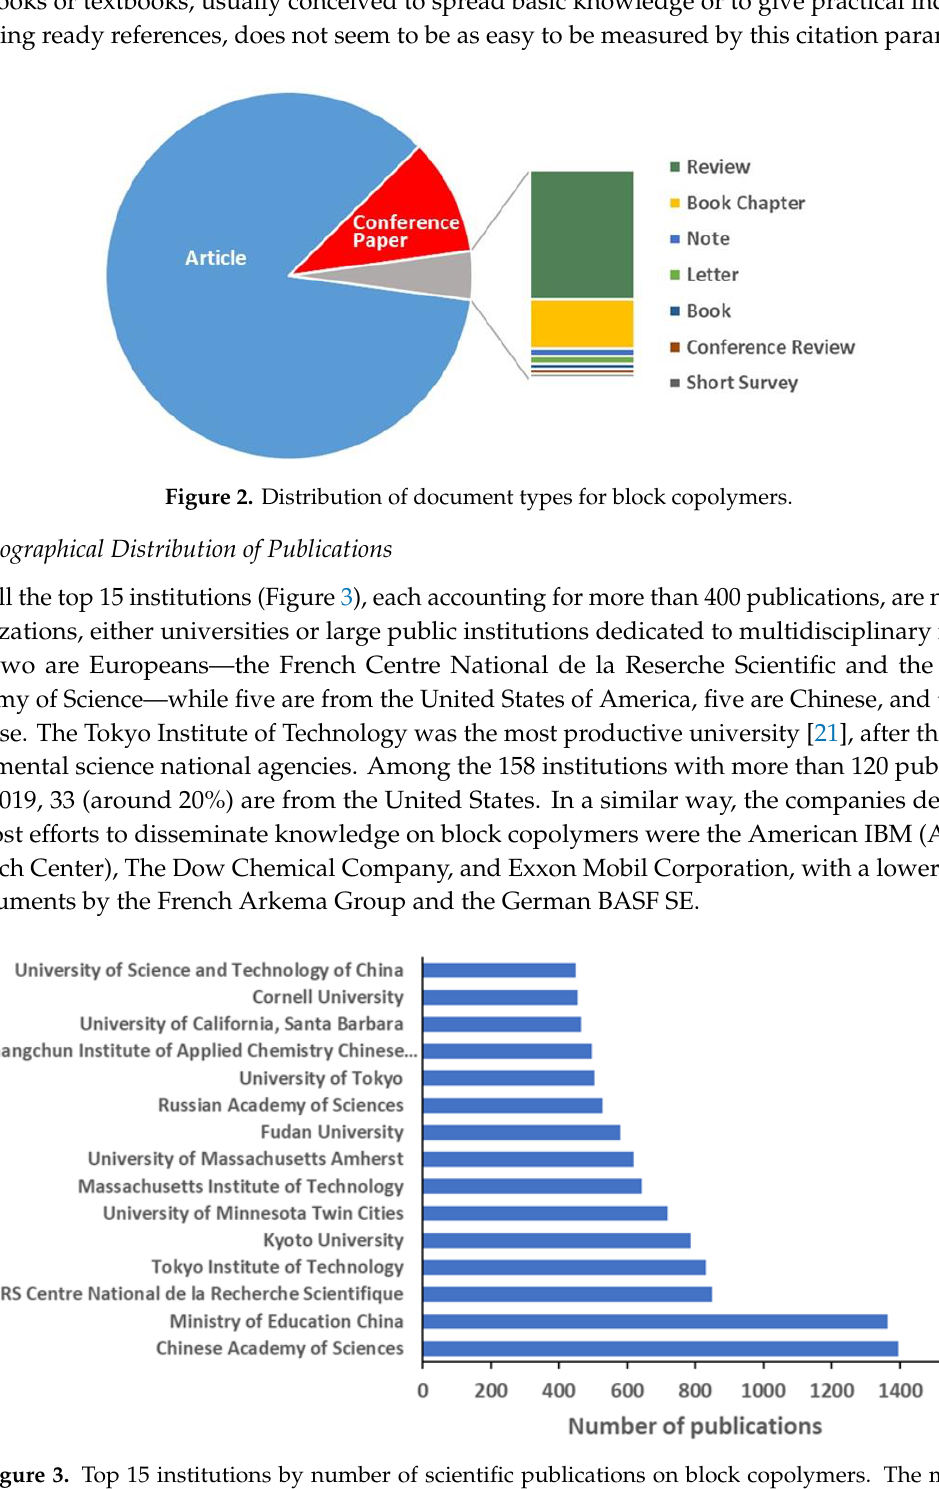
Figure 3. Top 15 institutions by number of scientific publications on block copolymers. The most cited publication of each institution is reported as reference by the decreasing order of number of publications [21 – 25,17,26 – 31,15,32,33].